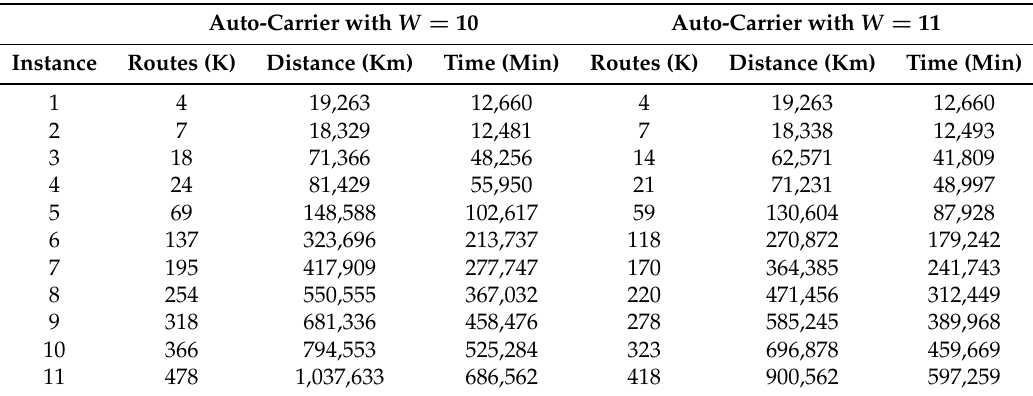
Table 6. Results of the main dealerships with different auto-carriers.